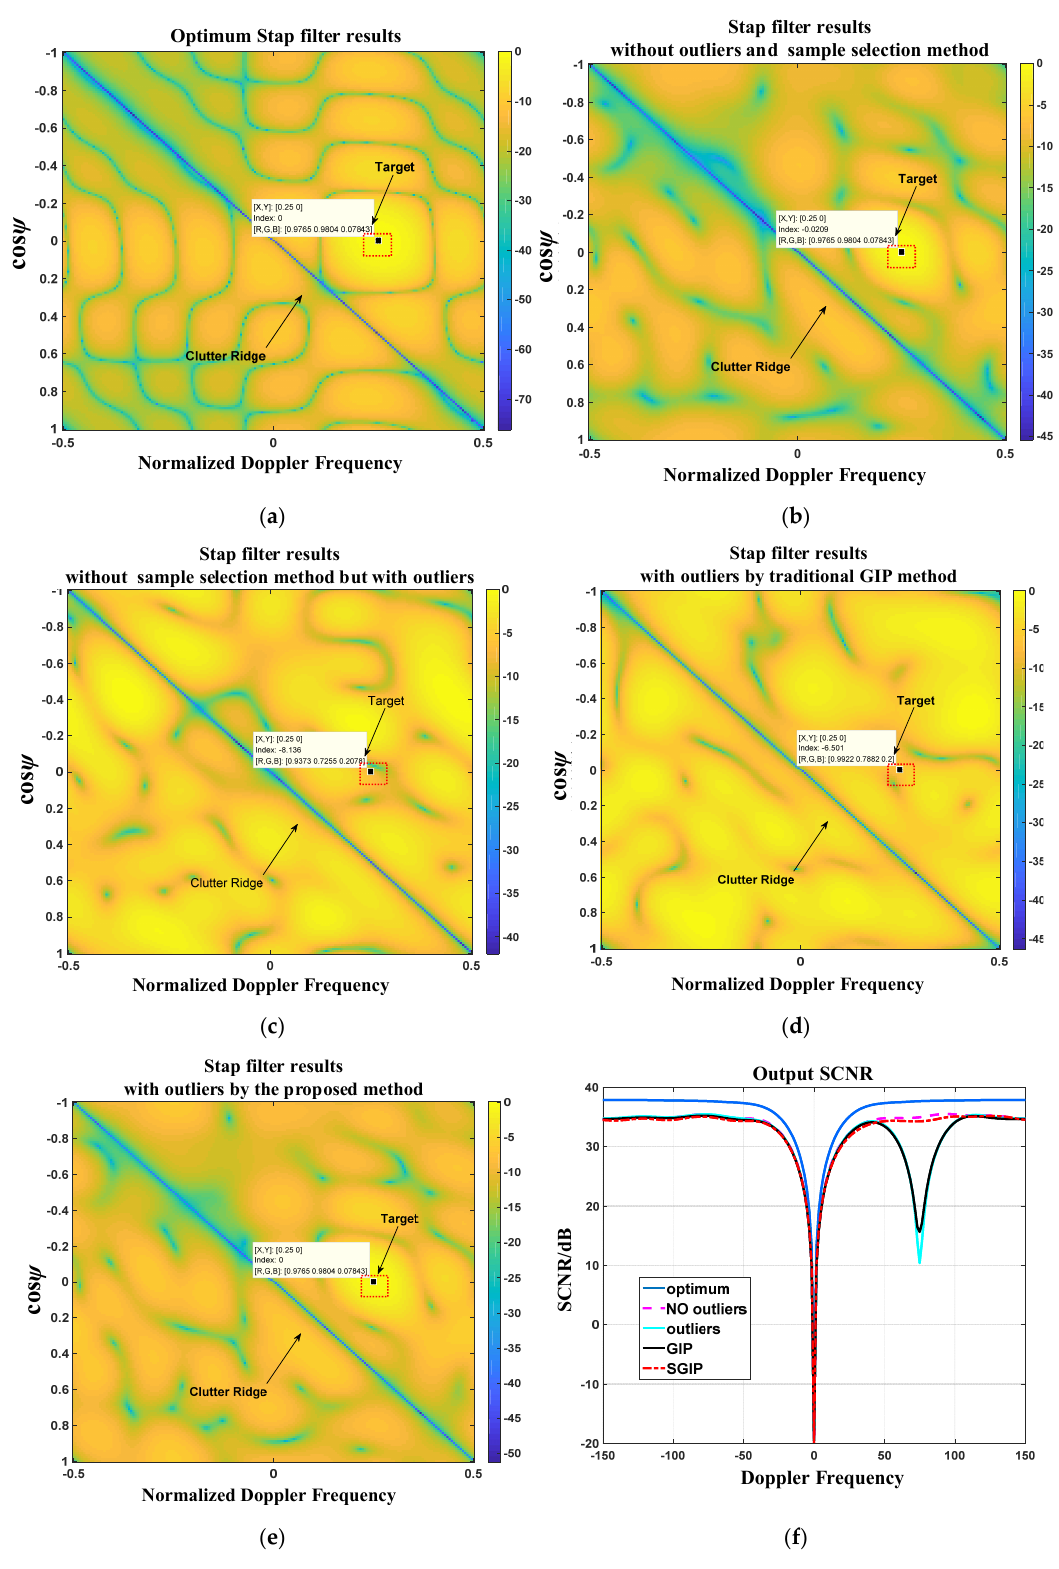
Figure 8. Simulation results of 2D space-time frequency response, they should be listed as: ( a ) Optimum STAP filter results (with actual ST − CCM); ( b ) STAP filter results without outliers and any sample selection method; ( c ) STAP filter results without any sample selection method but with outliers; ( d ) STAP filter results with outliers by traditional GIP method; ( e ) STAP filter results with outliers by the proposed method in this paper; ( f ) Comparison results of SCNR output by STAP filters with different methods.